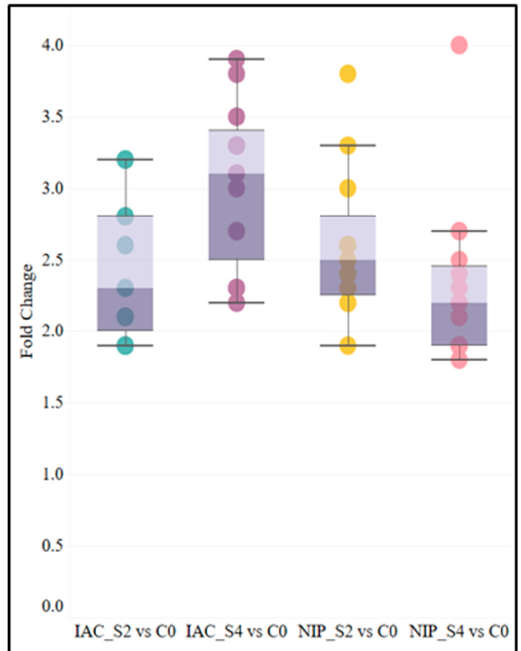
Figure 7. Box and whisker plots showing the spread of relative fold change of 11 HSP family proteins overexpressed in all conditions in both IAC1131 and Nipponbare. The shaded box indicates the interquartile range, while the color boundary within the shaded box indicates the median. The horizontal bars indicating the range of the data show the lesser value of either the minima or maxima or 1.5 times the interquartile range.